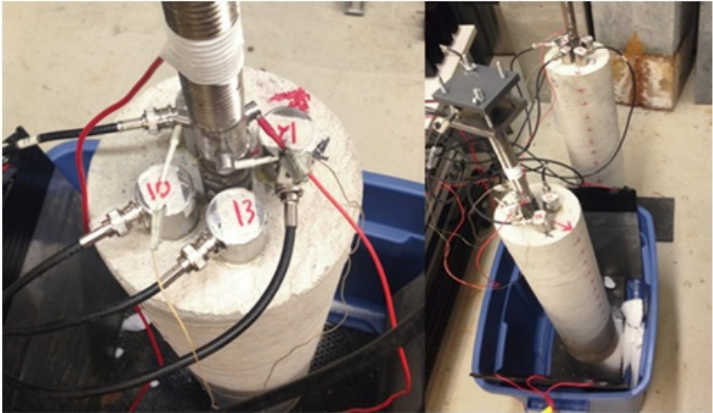
Figure 16. Acoustic Emission setup [31].